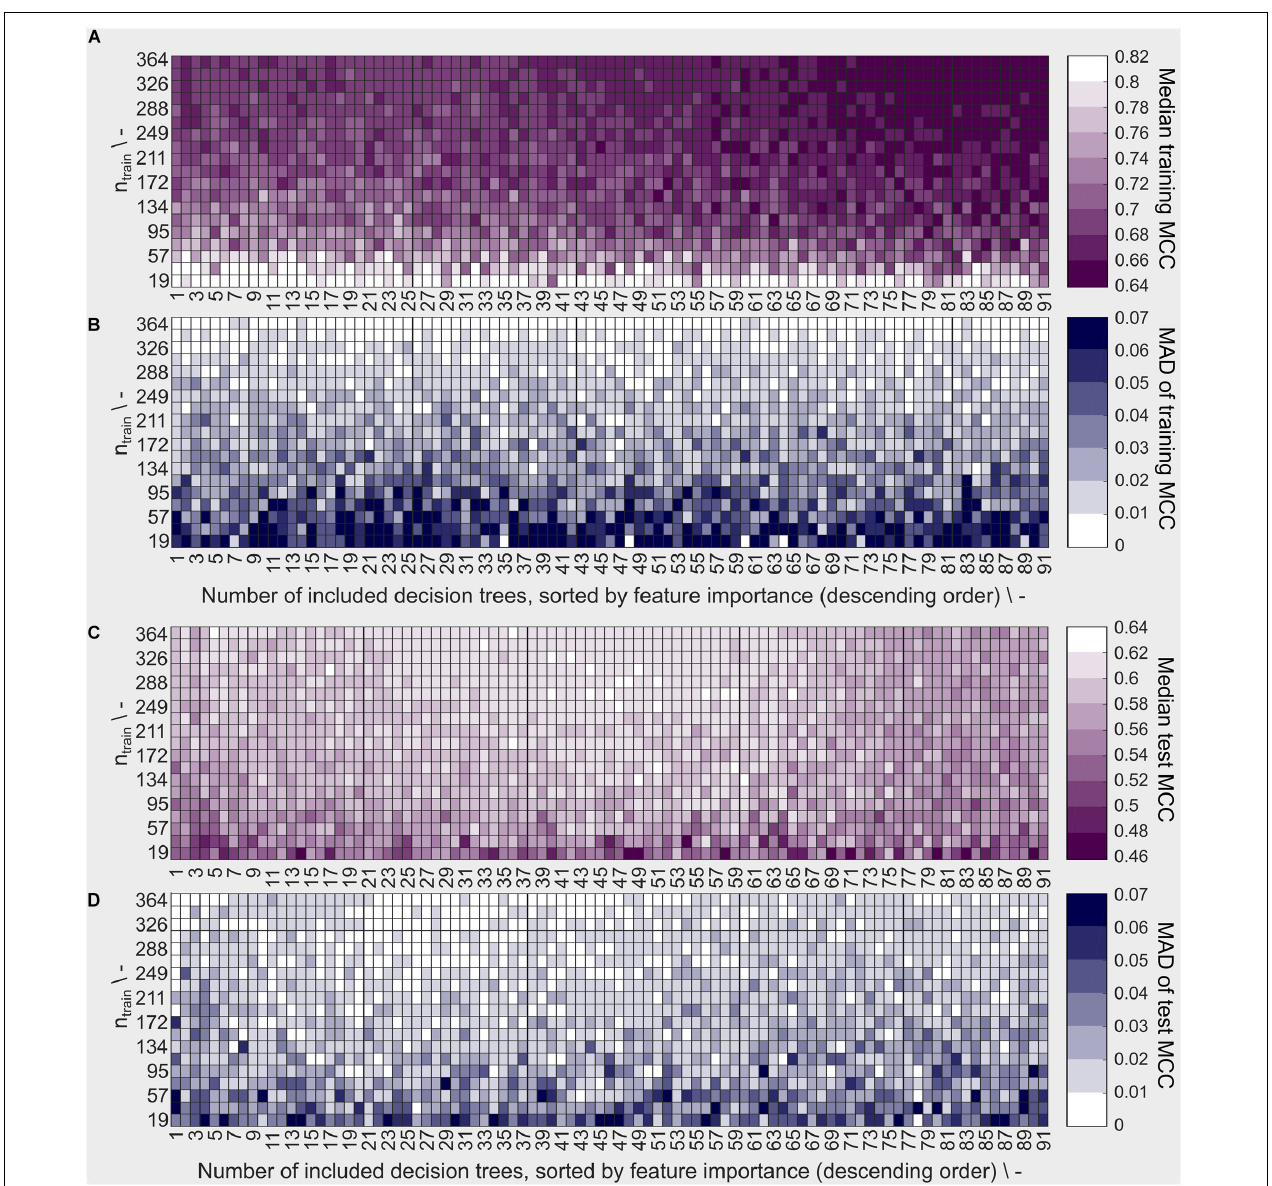
FIGURE 4 | Model performance based on training and external test data described by (A) the median Matthew’s correlation coefficient (MCC) and (B) the median absolute deviation (MAD) of the MCC for training data and (C) median MCC and (D) MAD of MCC for external test data. Each rectangle represents a decaplicate of a model with the number of training examples shown on the y-axis and the number of included decision trees in the ensemble classifier on the x-axis. The training observations were randomly sampled from the stratified dataset with n train = 384. The decision trees are sorted in descending order by feature importance. This means, that at point n on the x-axis, the results of the models including the n best decision trees are shown. White/bright color denotes high median MCC values and low MAD of the MCC, dark (violet or blue) color denotes low median MCC values and high MAD of the MCC, relative to all MCC data in the learning experiment. A well-predicting and reproducible model has high MCC and low MAD, respectively (both